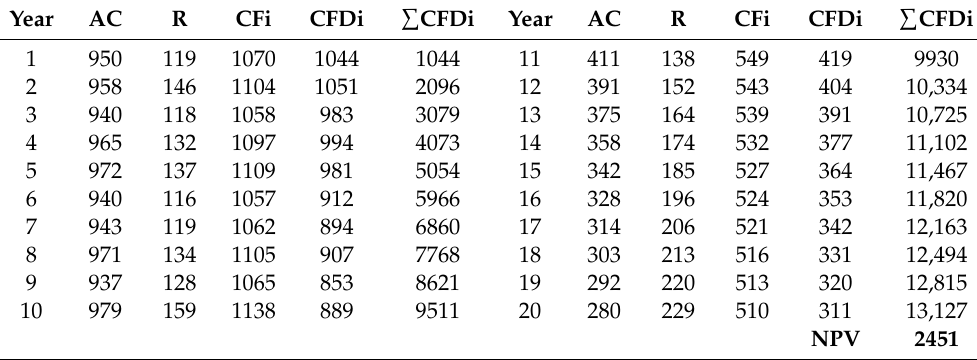
Table 12. Cash-Flow Analysis—Location 1, PV plant with Battery (cost investment, C 0 = 10,676 €